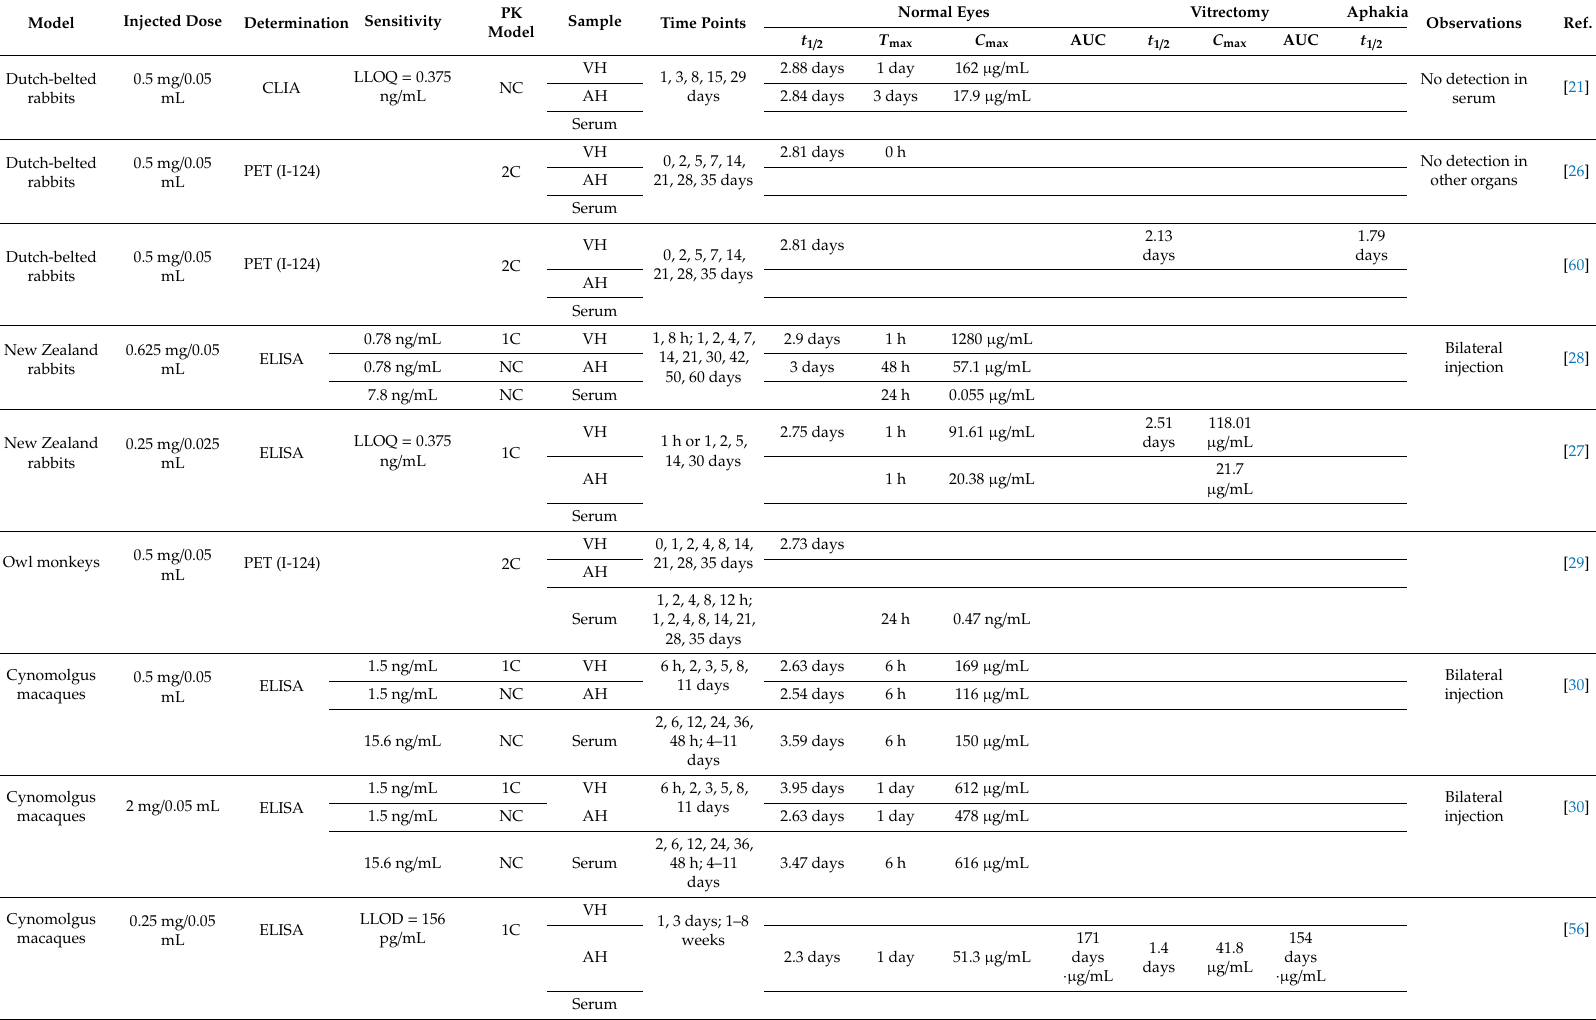
Table 2. Pharmacokinetic parameters of intravitreal ranibizumab in di ff erent